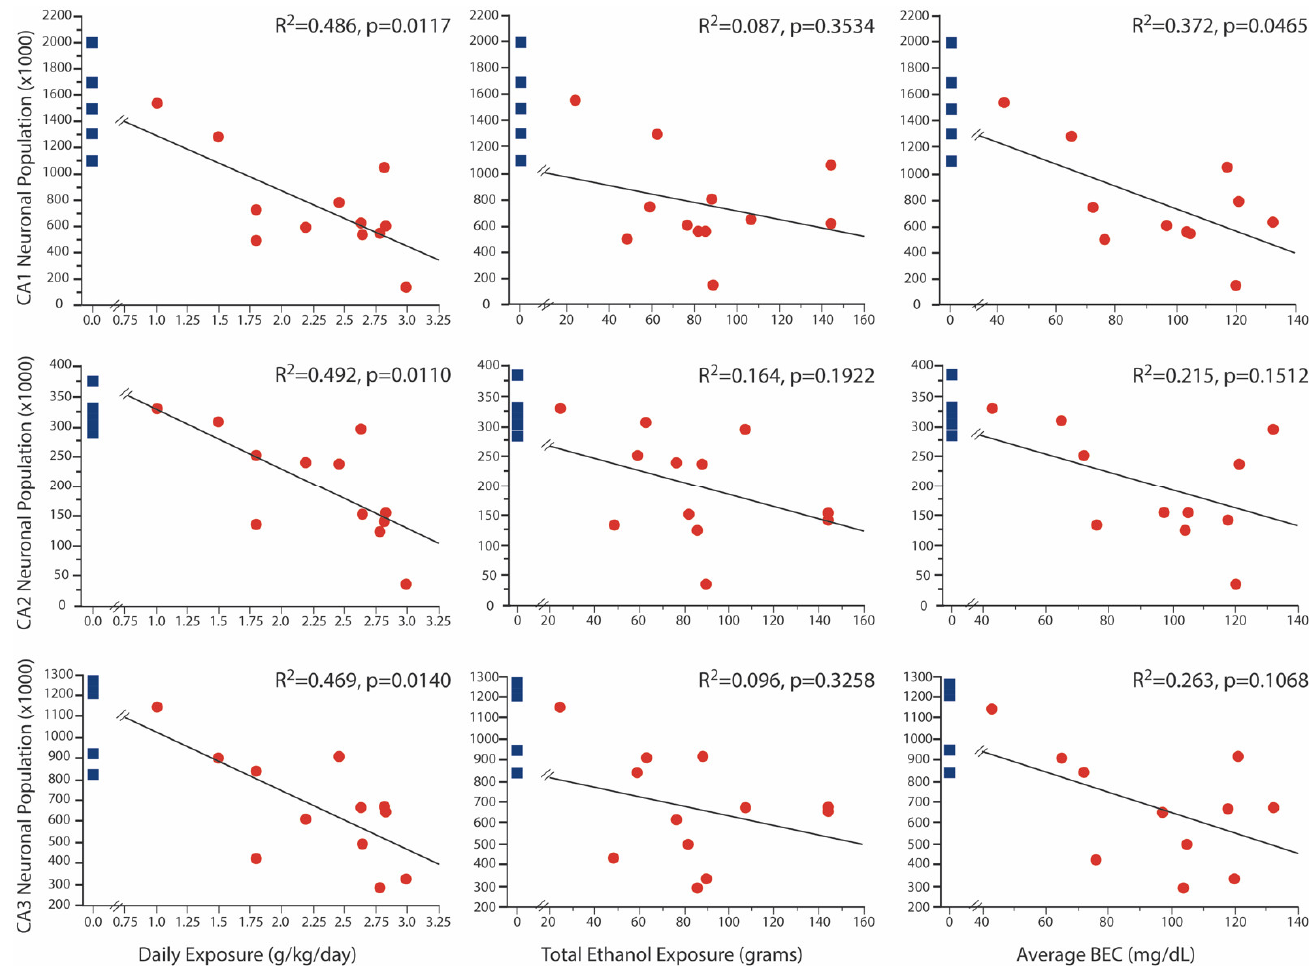
Figure 2. Correlation Between Neuronal Population and FAE. There was a negative correlation be- tween daily ethanol exposure and neuronal populations in all three regions. Neuron numbers in the CA1 region were also negatively correlated with BEC. Control values are shown for each correlation graph for illustration purposes only as they were not incorporated in the correlational analysis.